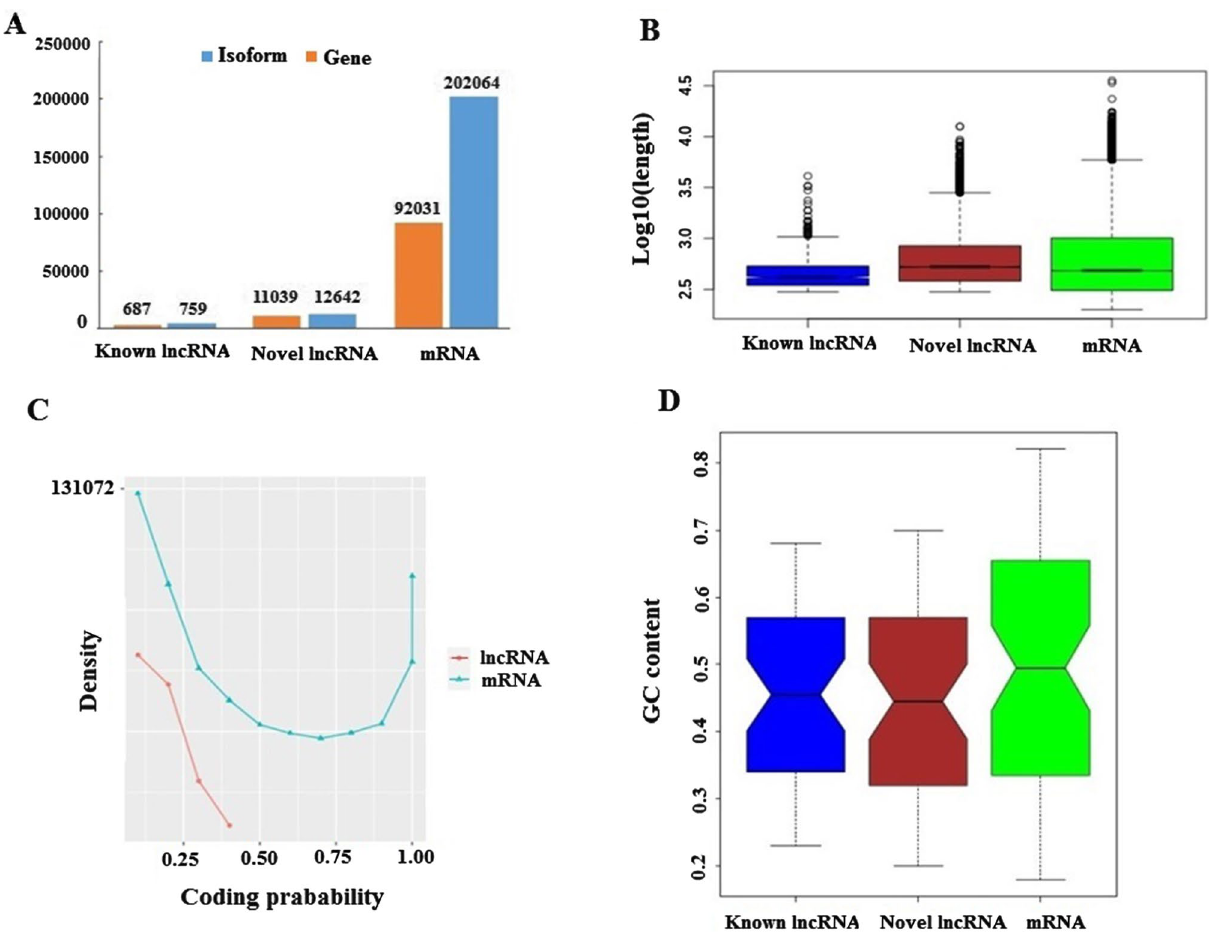
Figure 7. Characterization of A. crassicauda lncRNA. ( A ) Number of isoforms per gene ( B ) Length distribution of known lncRNA, novel lncRNA and, mRNA transcripts ( C ) Coding probability of known lncRNAs, novel lncRNAs and, mRNAs ( D ) GC content of known lncRNA, novel lncRNA and, mRNA